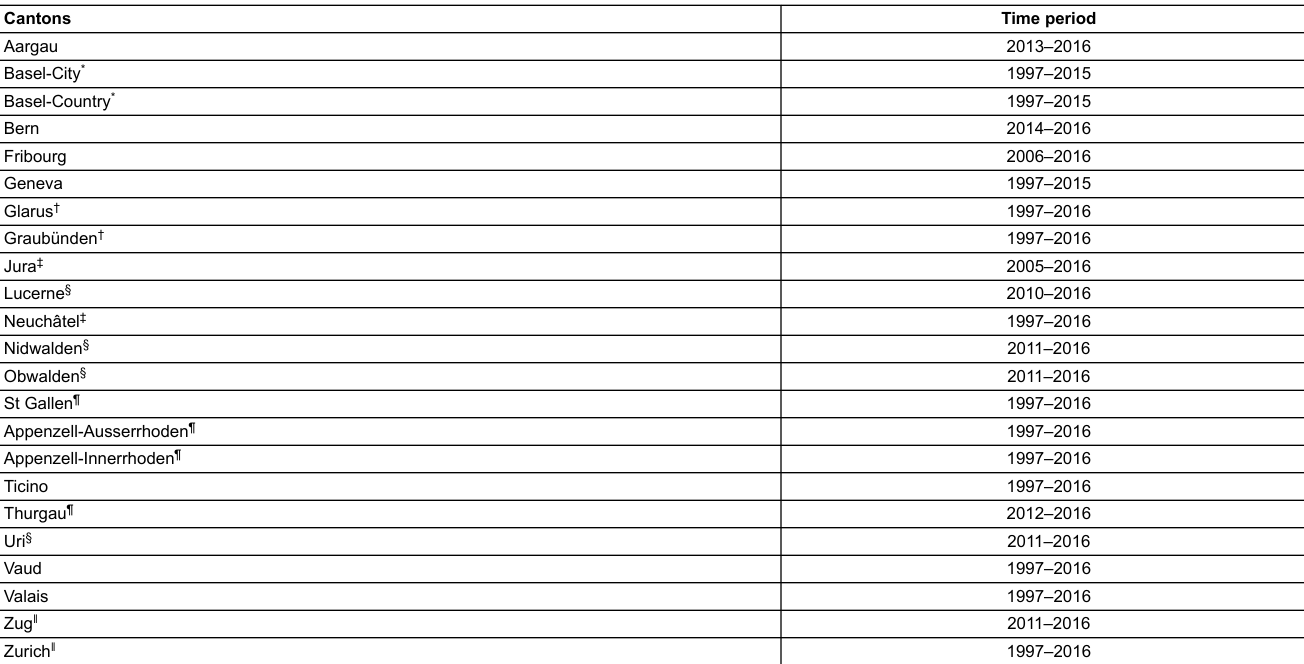
Table S1: Swiss cantons providing incidence data to the current analyses, with time periods. Cantons